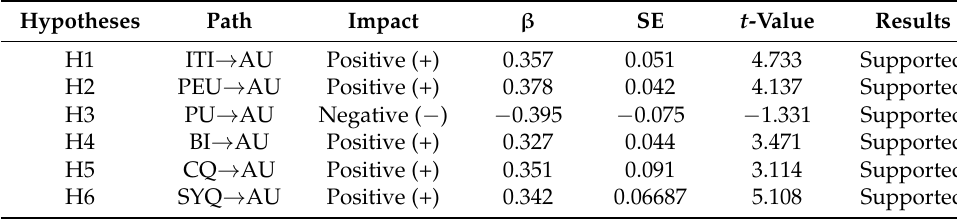
Table 4. Results of structural equation modelling